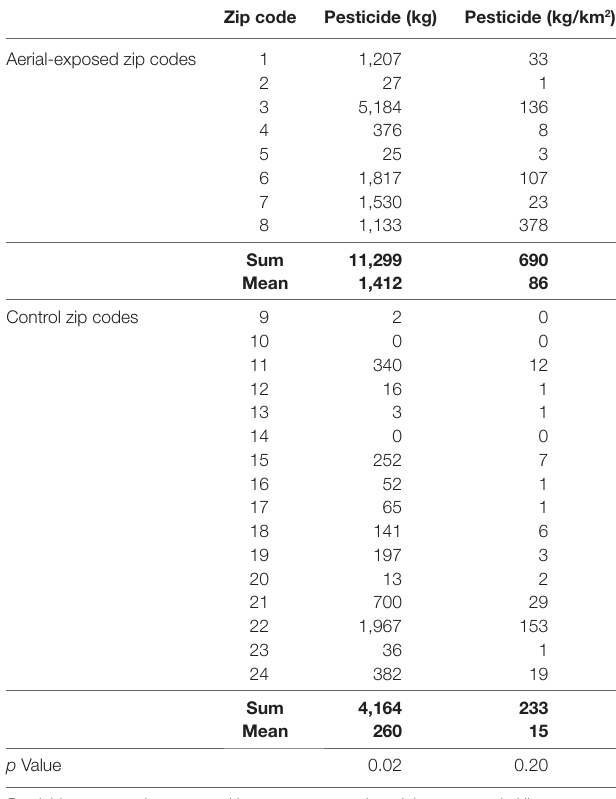
TaBle 3 | average yearly pesticide burden for control and aerial-exposed zip codes.